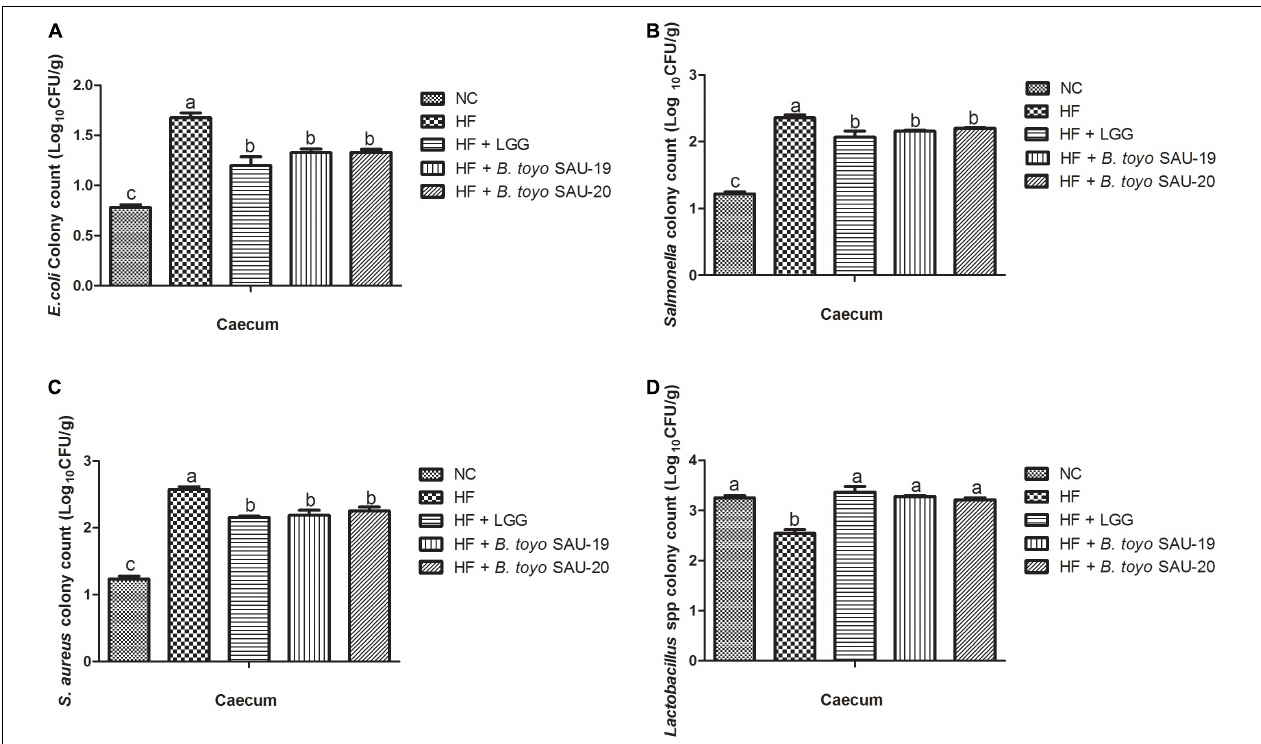
FIGURE 8 | Effects of Bacillus toyonensis SAU-19 and SAU-20 on bacteria enumeration in cecum contents of mice fed high fat diet (A) colony count of Escherichia coli, (B) colony count of Salmonella spp., (C) colony count of Staphylococcus aureus, (D) colony count of Lactobacillus spp. Bars represent means ± standard deviation (SD). The values are presented as the mean ± SD. Bars without the same letter differed significantly ( n = 6, P < 0.05) the same. NC, mice were administered normal diet + normal saline; HF, mice were fed high fat diet + normal saline; HF + LGG, mice were administered high fat diet + 10 6 Lactobacillus rhamnosus GG; HF + B. toyo. SAU-19, mice were administered high fat diet + 10 6 Bacillus toyonensis SAU-19 from A. adenophora ; HF + B. toyo. SAU-20, mice were administrated with high fat diet + 10 6 Bacillus toyonensis SAU-20 from A. adenophora